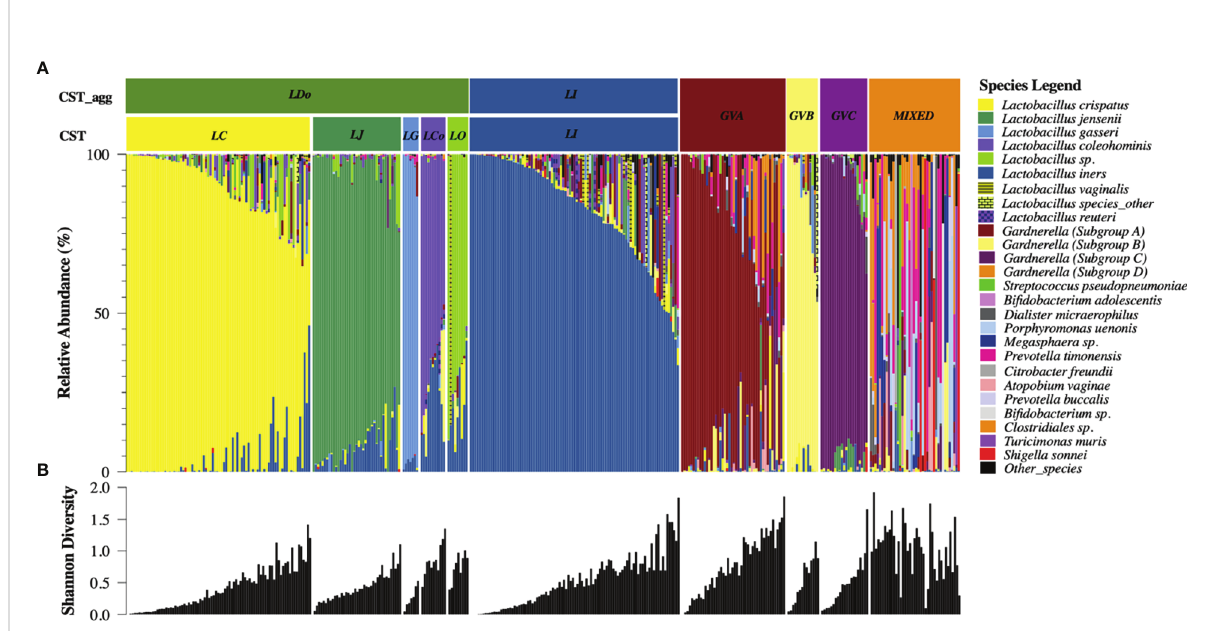
FIGURE 1 cpn 60 microbial pro fi ling of cervicovaginal samples reveals six aggregated microbial community structures with variable alpha diversity (A) Cervicovaginal microbial pro fi les obtained using cpn 60 sequencing from 362 cervicovaginal secretion samples collected from 41 study participants. Pro fi les were organized by descending relative abundance and aggregated into six functional microbial clusters (CST_agg). The 25 most prevalent microbial taxa are shown with the rest of the species grouped as “ other_species ” and “ Lactobacillus_other_species ” . CST – refers to the raw community state type as determined using hierarchical clustering, CST_agg - aggregated CSTs where Lactobacillus (non-iners) dominated communities were further aggregated for analysis consistent with current literature. The six aggregated CSTs determined by the dominating microbial taxa are: LDo - Lactobacillus (non-iners) dominance, LI - L. iners dominance, GVA - Gardnerella subgroup A dominance, GVB - Gardnerella subgroup B dominance, GVC - Gardnerella subgroup C dominance, MIXED – polymicrobial community structure. (B) Shannon diversity measure of community alpha diversity shown per corresponding